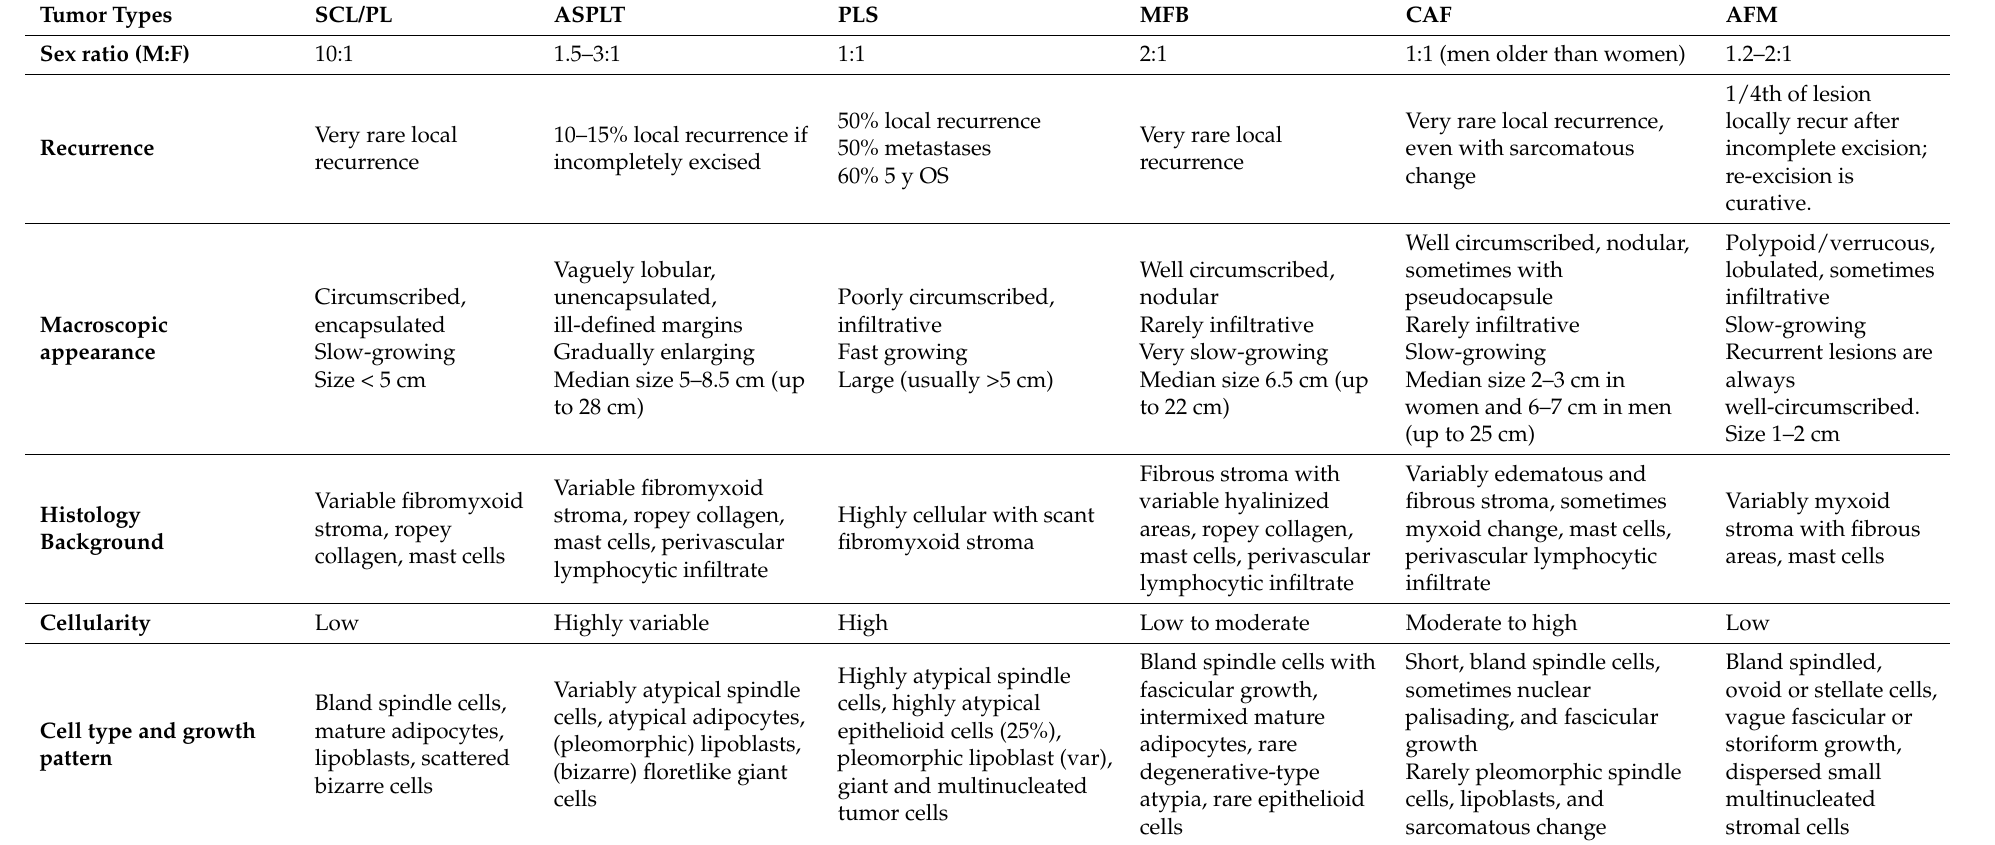
Table 1. Summary of the clinical, histopathological and molecular characteristics of RB1 -Deleted Mesenchymal